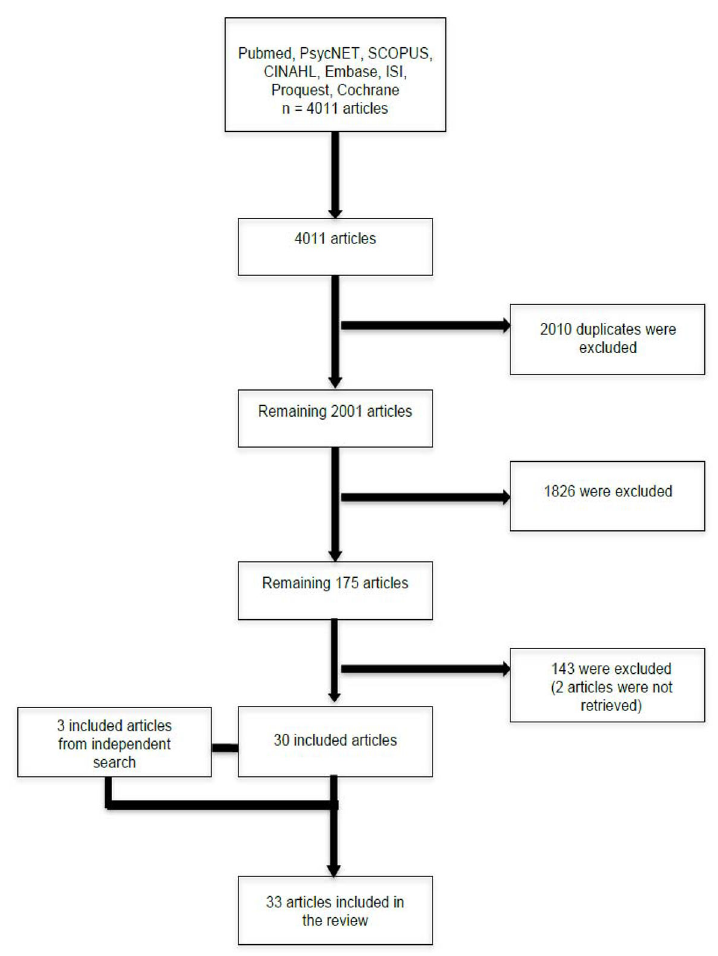
Figure 1. Article selection following each